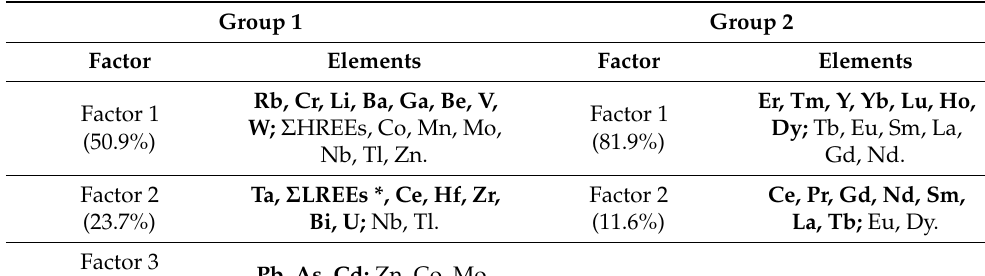
Er, Tm, Y, Yb, Lu, Ho, Factor 1 Dy; Tb, Eu, Sm, La, (81.9%) Gd, Nd. Ce, Pr, Gd, Nd, Sm, Factor 2 La, Tb; Eu, Dy. (11.6%)